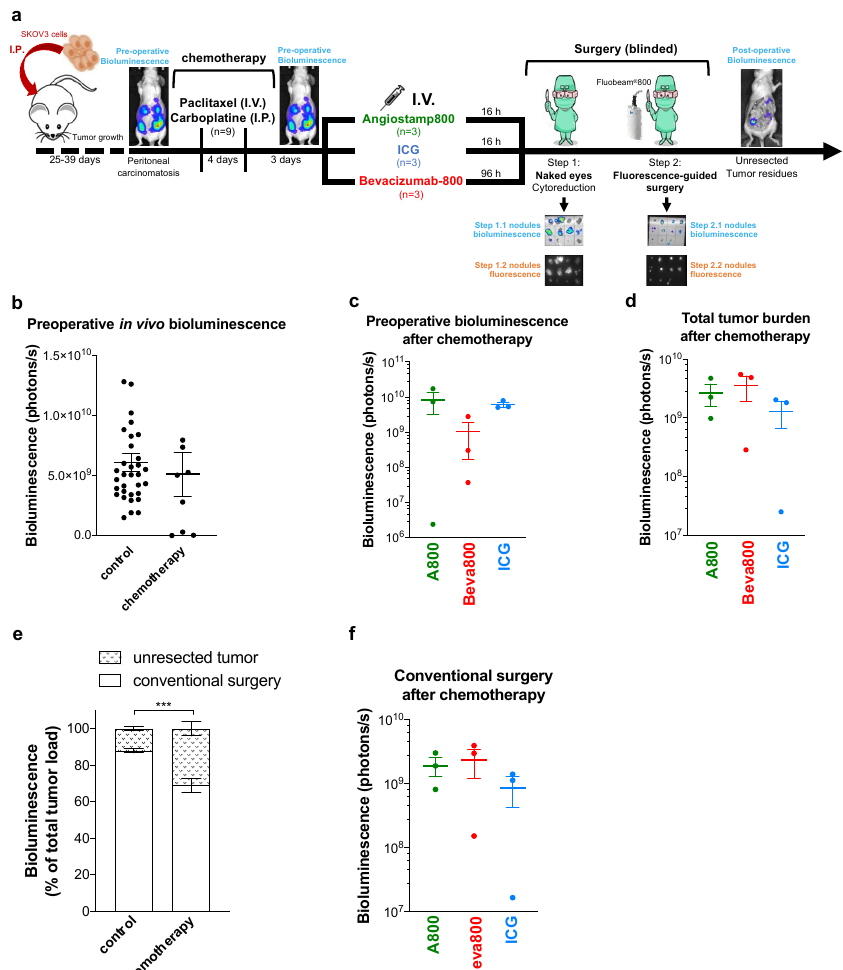
Figure 3. Neoadjuvant chemotherapy decreased peritoneal carcinomatosis. ( a ): Schematic representation of orthotopic peritoneal carcinomatosis growth, treatment, and blinded surgery plan. Mice with well-established peritoneal carcinomatosis were treated with two doses of chemotherapy (paclitaxel 10 mg/kg i.v. + carboplatin 40 mg/kg i.p.) at 4-day intervals. Three days later, mice were imaged with in vivo bioluminescence imaging and distributed into three groups of mice treated by intravenous (I.V.) administration of Angiostamp800 ( n = 3), or ICG ( n = 3) for 16 h, or Bevacizumab-IRDye 800CW ( n = 3) for 96 h. Conventional surgery was first performed, followed by NIR-fluorescence-guided surgery. The mouse body was finally exposed to bioluminescence imaging. The bioluminescence and fluorescence of all surgical samples were measured ex vivo. ( b ): In vivo noninvasive bioluminescence imaging 3 days after chemotherapy in non-treated and chemotherapy-treated mice. ( c ): In vivo preoperative bioluminescence imaging 3 days after chemotherapy showed no significant difference between the groups. ( d ): Total tumor burden after chemotherapy showed the sum of ex vivo bioluminescence of tumor nodules resected by conventional and fluorescence-guided surgery and tumor residues left in mouse body, without significant difference between the groups. ( e ): Bioluminescence of tumor resected by conventional surgery and of unresected tumor residues expressed as a percentage of total tumor load in mice operated with ( n = 9) or without (control, n = 33) neoadjuvant chemotherapy (mean ± SEM). *** p < 0.001; two-way ANOVA with Sidak post-hoc tests. ( f ): Bioluminescence signal of tumor nodules resected by conventional surgery after neoadjuvant chemotherapy in mice showed no significant difference between the groups. ( b – d , f ): Each dot represents one mouse. Bars, mean ±